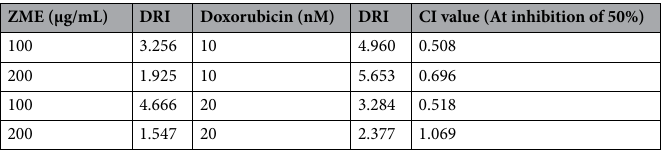
Table 1. CI and DRI for drug combination by ZME and